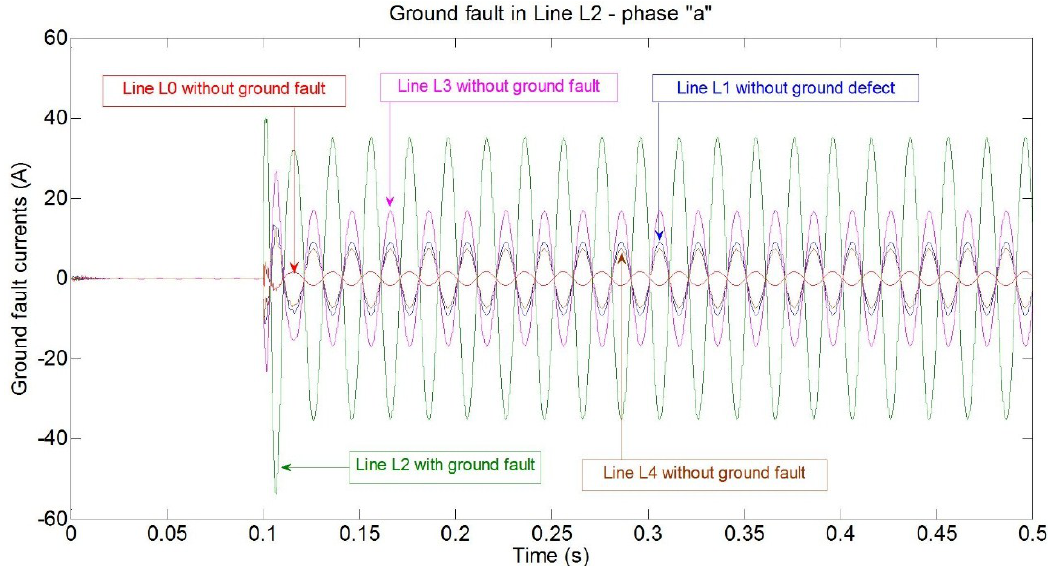
Figure 15. Ground fault currents at main distribution busbars. Single ground fault at phase “ a ”—Line